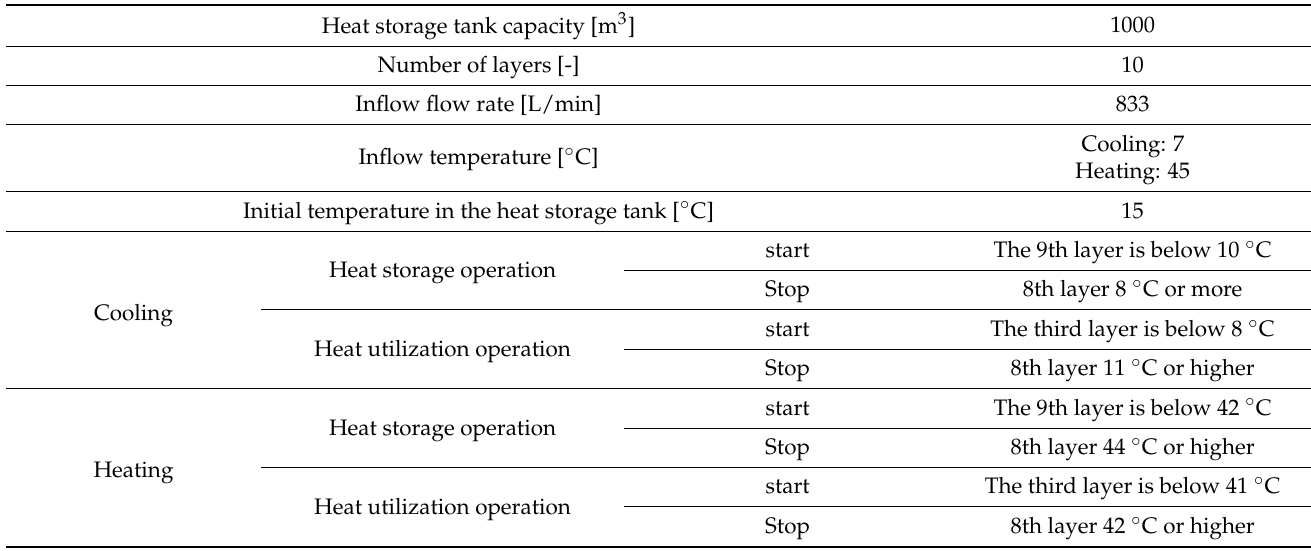
Figure 1. The stratum diagram of the heat storage well. GW_AC is flow rate from secondary side [m 3 /h], GW_MC is flow rate from water-cooled HP [m 3 /h], GW_ST is flow rate between layers [m 3 /h], T_AC is inflow temperature from secondary side [°C], T_MC is inflow temperature from heat source [°C], T_1 is temperature of layer 1 [°C], and T_N is temperature of layer N [°C]. Table 1. The WTES system model settings.